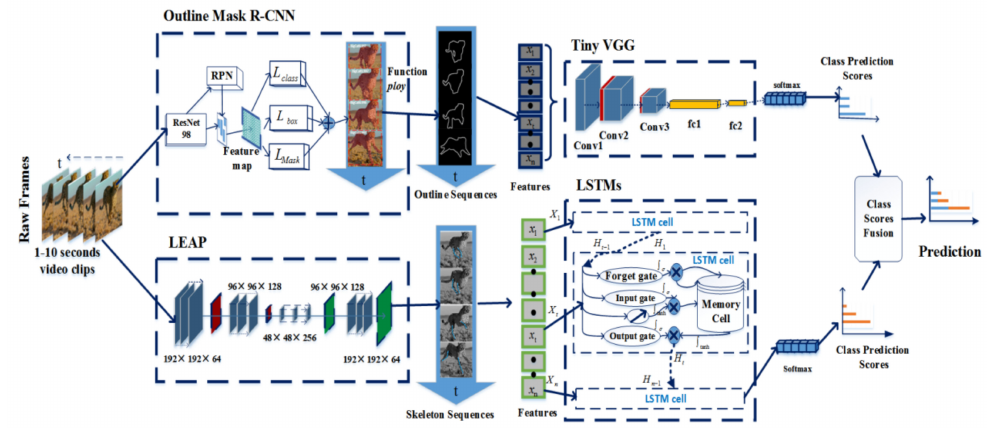
Figure 2. Workflow of the wild feline action